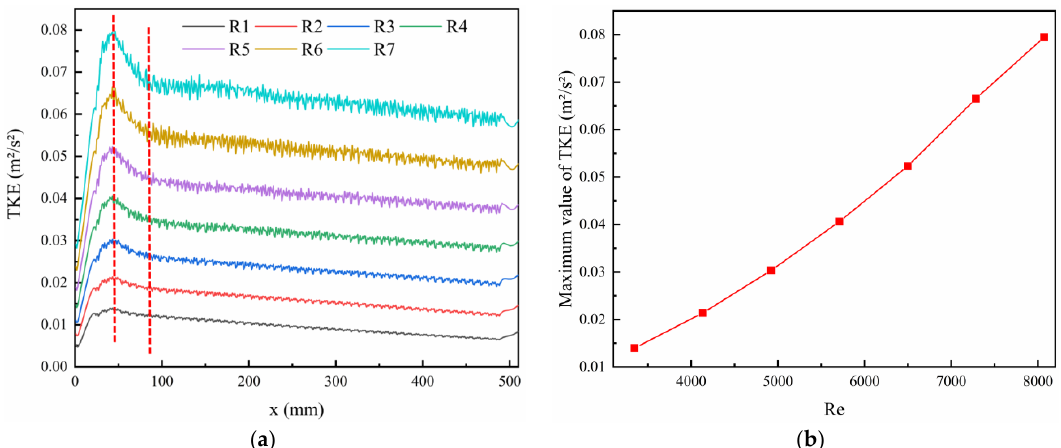
Figure 9. Distributions of turbulent kinetic energy ( a ) and its maximum value ( b ).